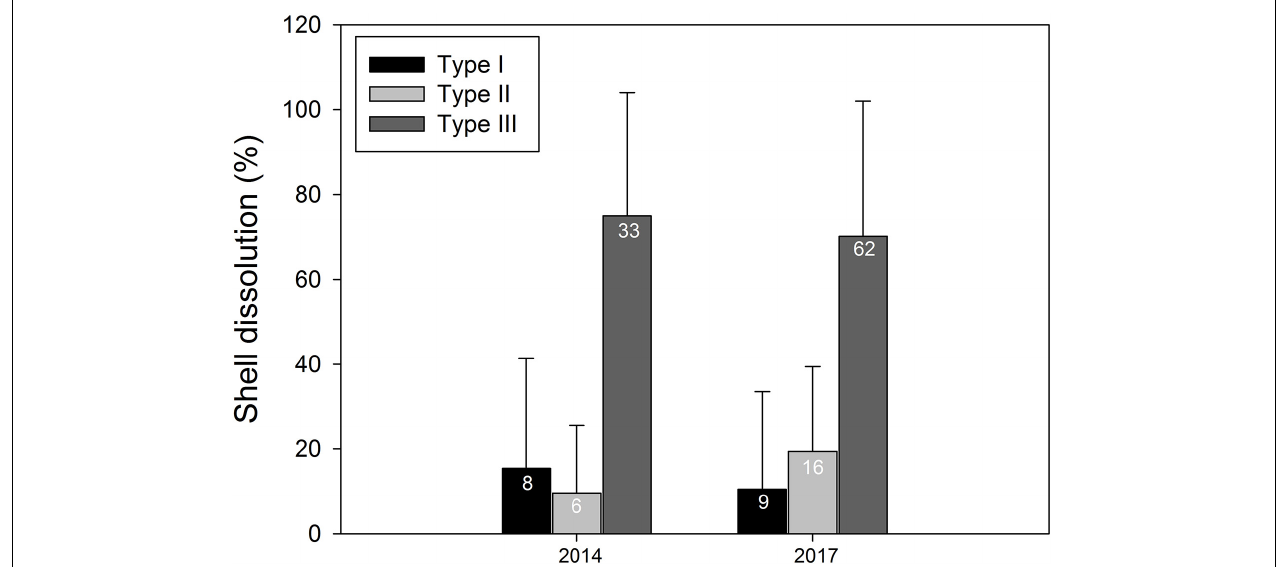
FIGURE 6 | Limacina helicina dissolution severity in 2014 and 2017. Sample size (n) indicated on each bar.